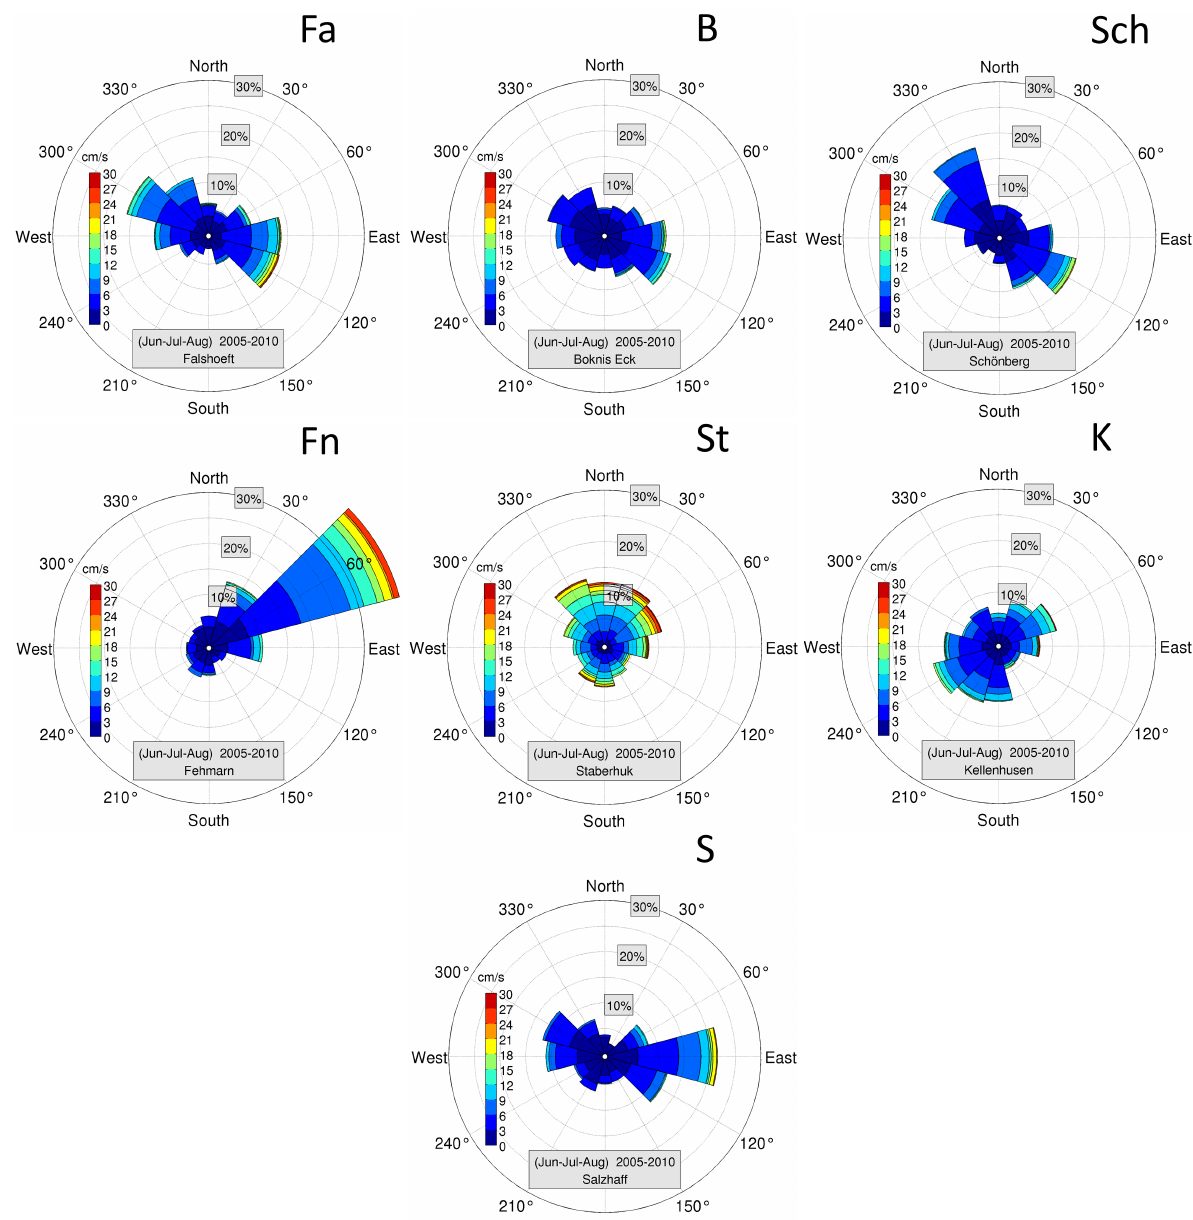
Fig. 2. Distribution of current regimes at the seven stations, averaged over all six years of the survey. Degrees indicate the current directions (by segments of 30 ◦ ), percentages give the commonness of a given current direction, the colour coding indicates the average speed of currents in a given directional segment. (A) through (G) are the summer current regimes at the different stations Fa through